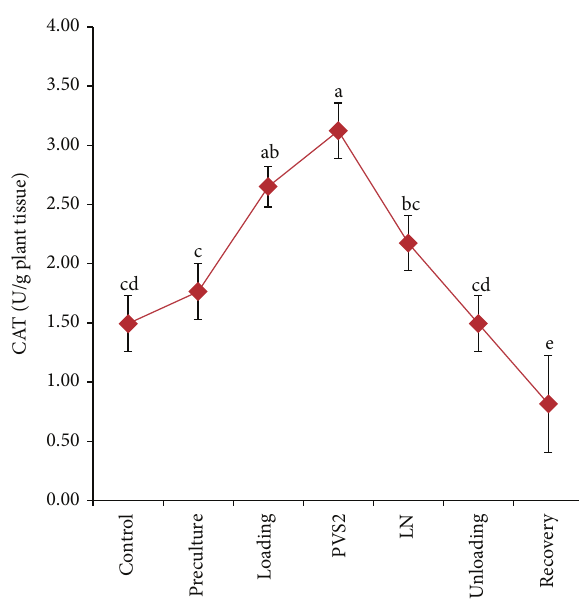
Figure 7: Changes in catalase (CAT) enzyme activity at various stages of the cryopreservation.Results were analysed using one- way ANOVA. Means followed by the same alphabet were not sig- nificantly different using Tukey